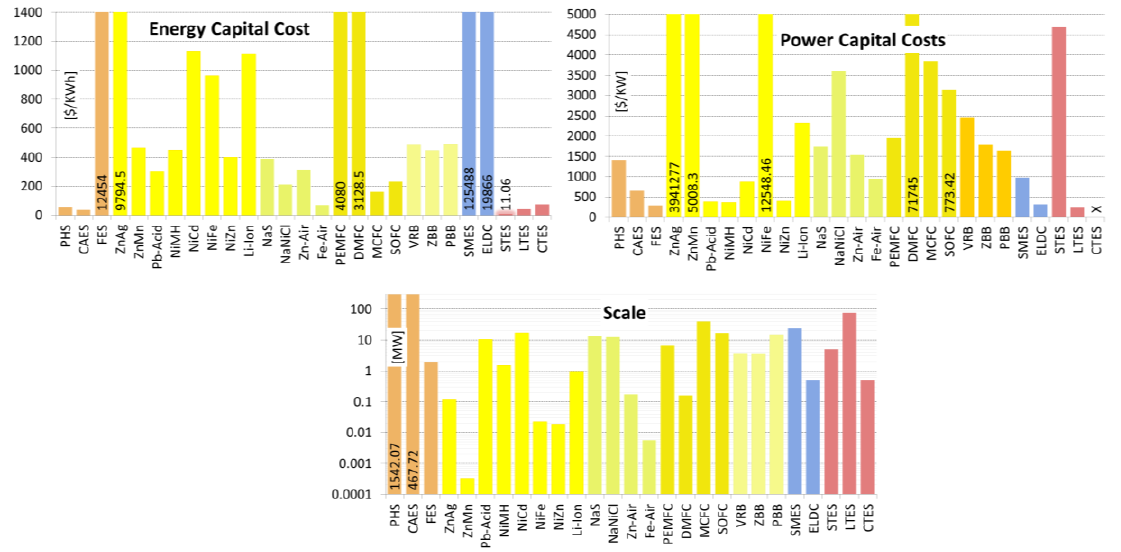
Figure 14. Comparing cost and scale of technologies with respect to each other. Data points marked with “X” are